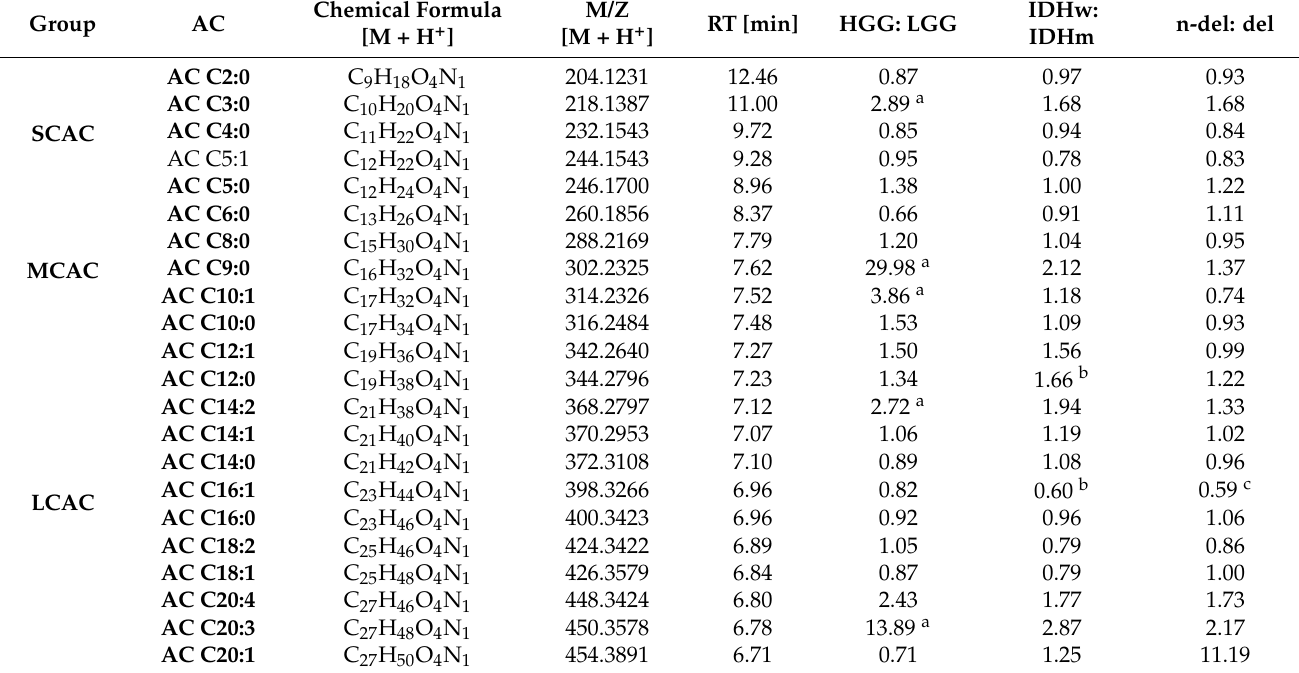
a the average normalized peak area for HGG is statistically significantly different from LGG, p < 0.05; b the average normalized peak area for IDHw is statistically significantly different from IDHm, p < 0.05; c the average normalized peak area for n-del is statistically significantly different from del, p <